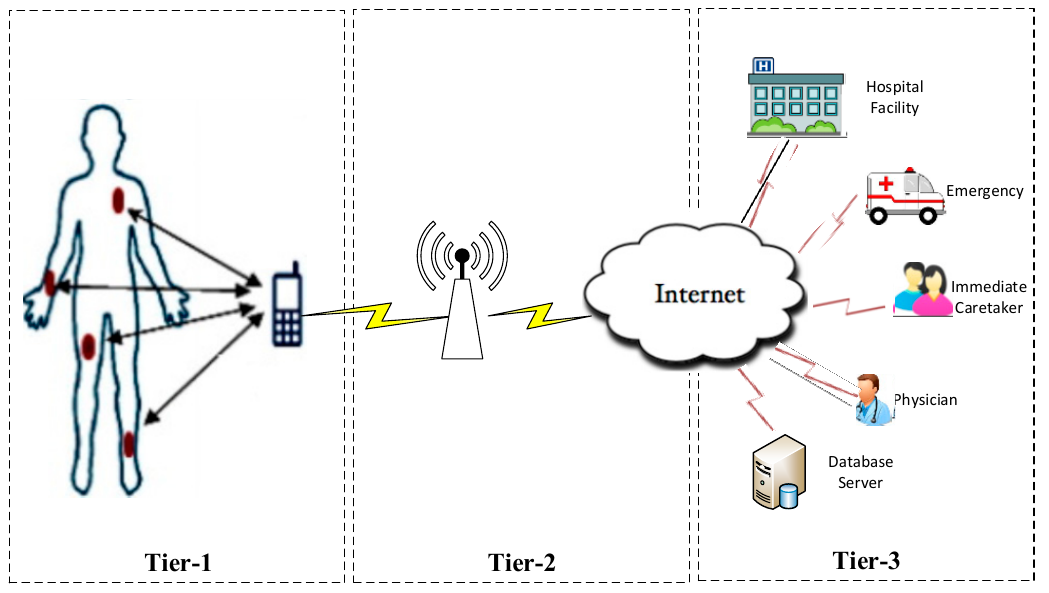
Figure 1. Architecture of WBAN communications.